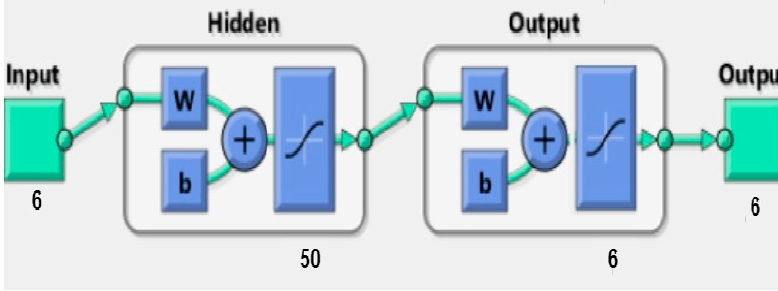
Figure 8. Architecture developed for the neural network.